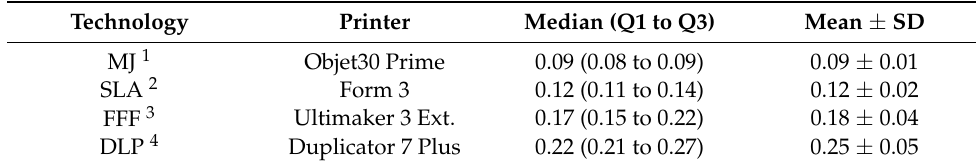
Table 3. Summary of the accuracy (trueness) of RMS values for each printer.